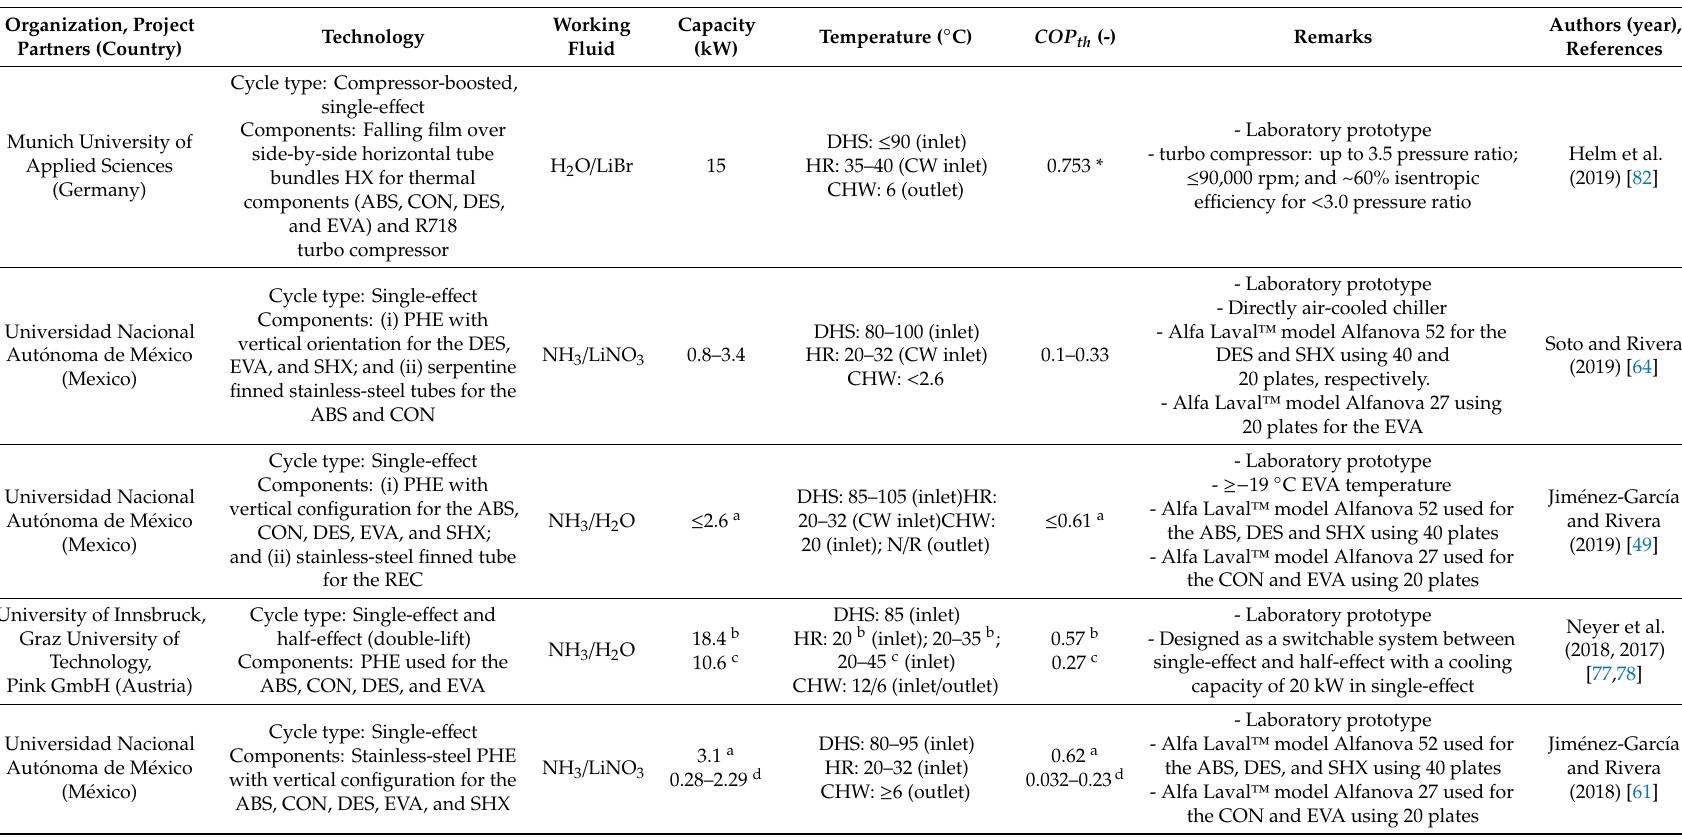
Table 2. Research projects on small capacity laboratory and pre-industrial prototypes with special features suitable for solar space cooling applications. Organization, Project Partners